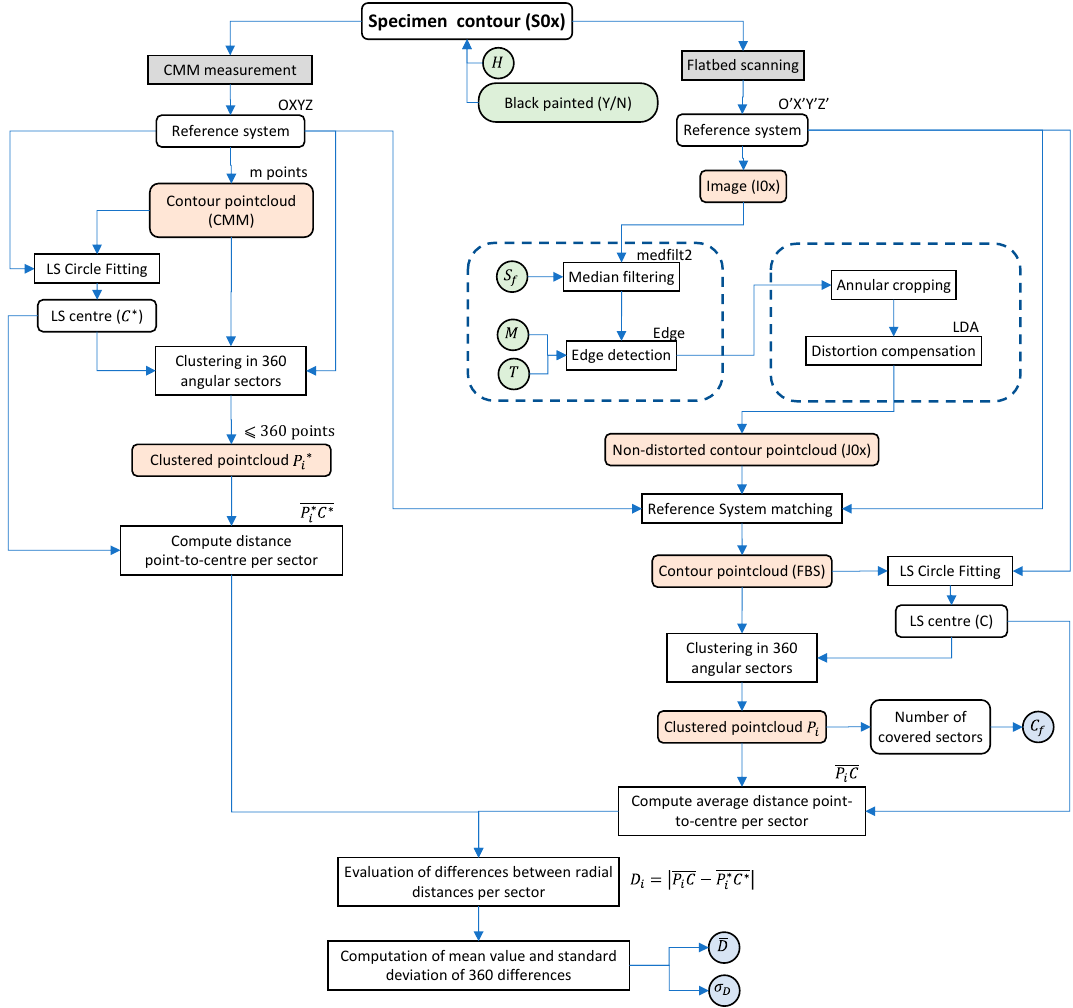
Figure 2. Schematic flowchart of the experimental